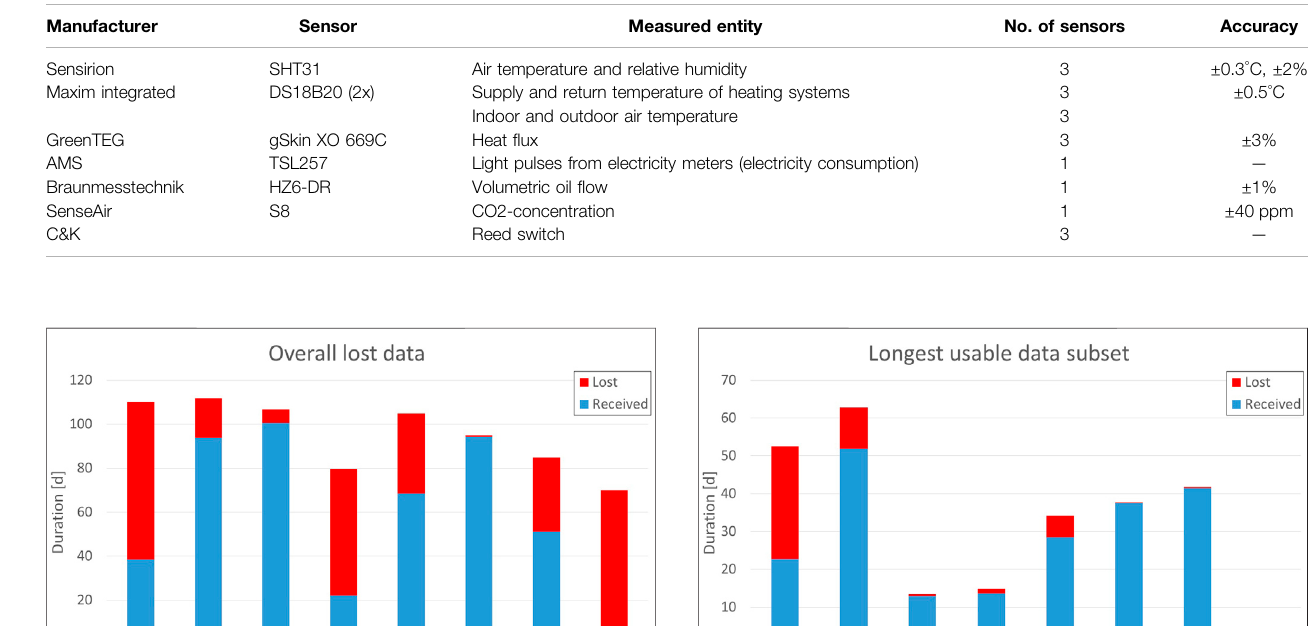
TABLE 2 | Details of the sensors used for the case study sensor kit.